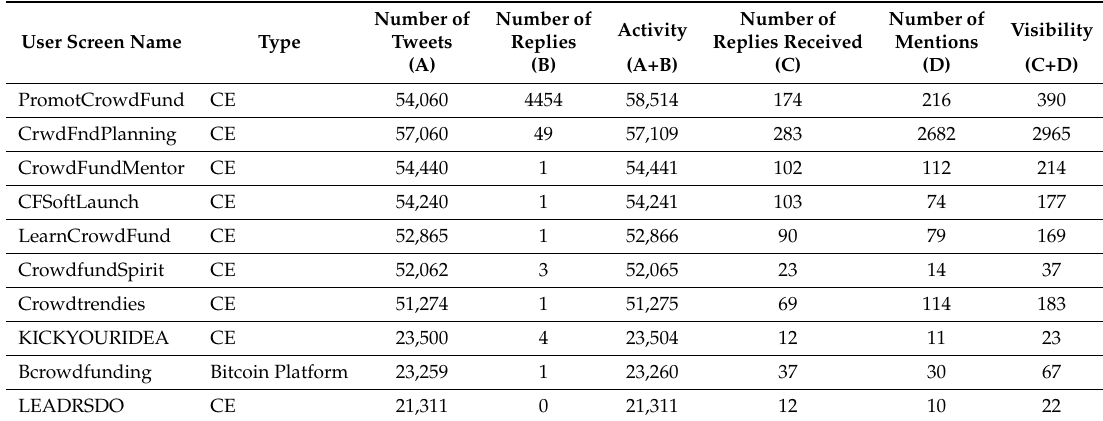
Table 2. Top 10 Most Active